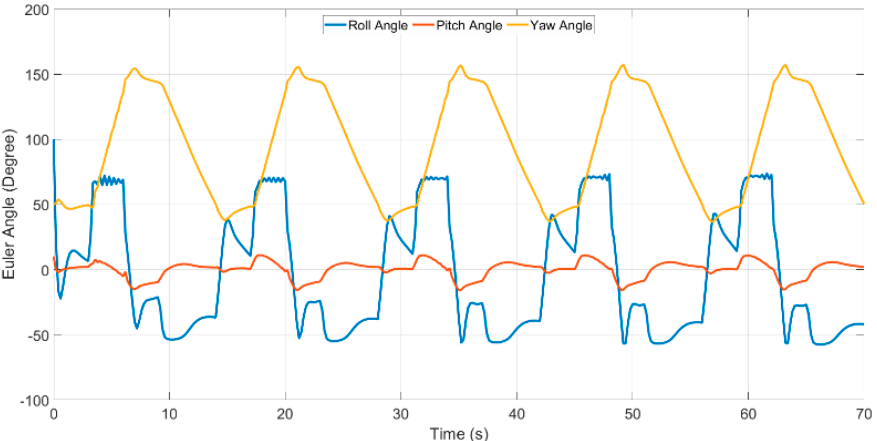
Figure 14. The Euler angles change during the dynamic soaring.